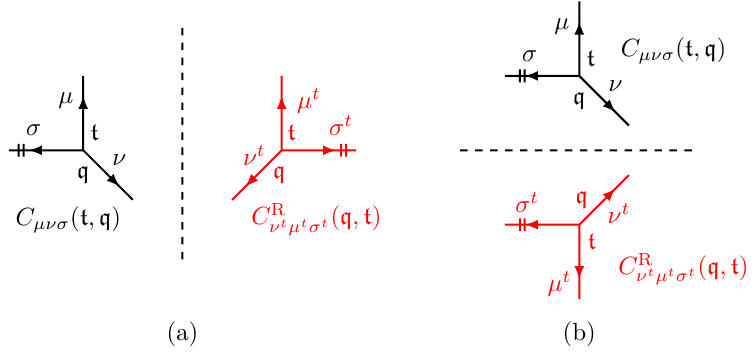
Figure 3 . The usual vertex factor C and the reflected vertex factor C R . (a) is for the case of ON-plane reflection and (b) is for the case of O5-plane reflection.